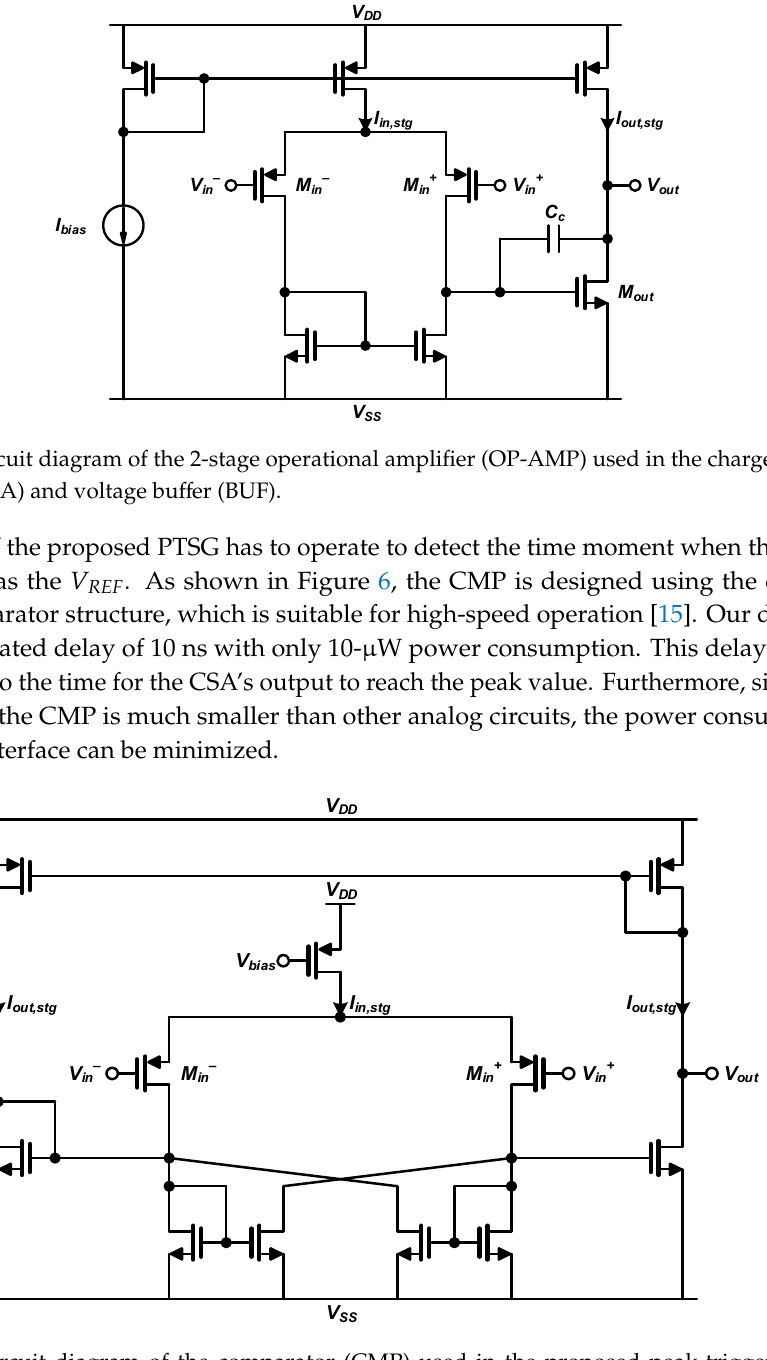
Figure 6. Circuit diagram of the comparator (CMP) used in the proposed peak-triggered signal generator (PTSG).